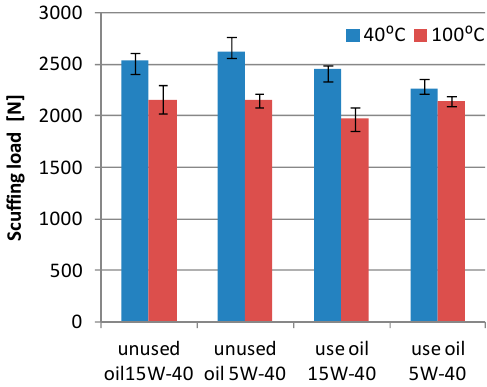
Figure 8. Scu ffi ng load of the unused and used oil; 15W-40 and Figure 8. Scuffing load of the unused and used oil; 15W-40 and 5W-40 .